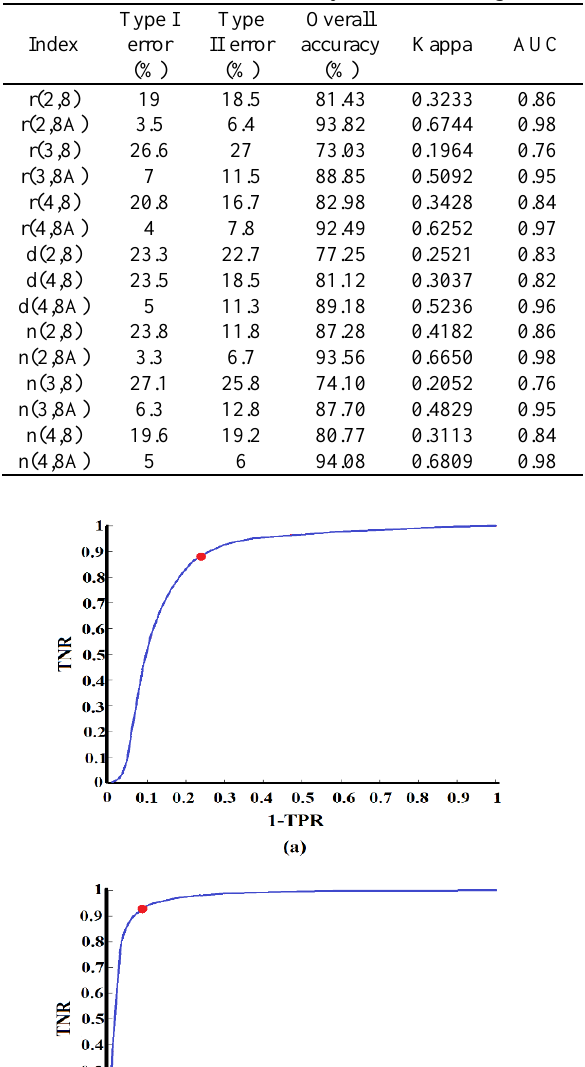
Table 2. Extracted indices and their corresponding ideal